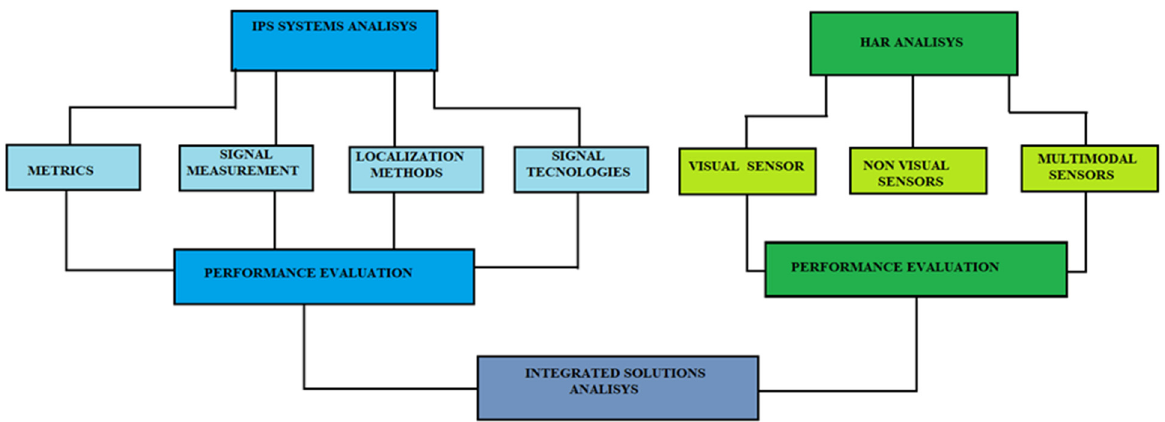
Figure 2. Diagram of relationships between the sections.